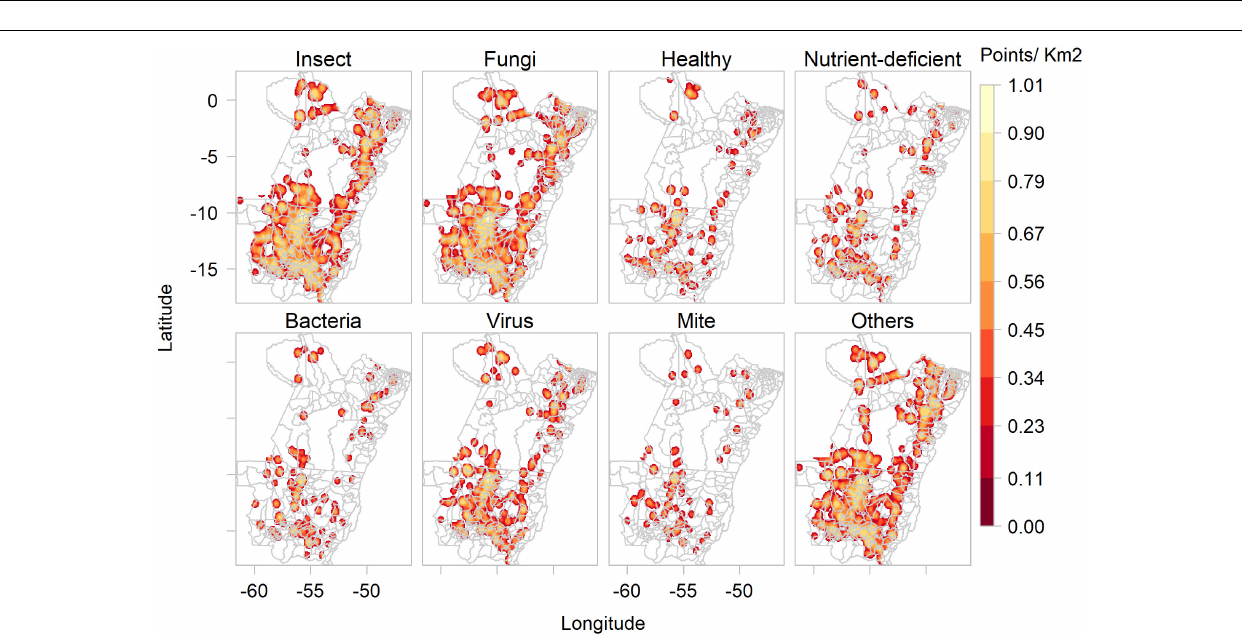
FIGURE 4 | Kernel density of images collected by Plantix users in Mato Grosso and Pará, Brazil, between November 2016 and May 2020, according to predicted crop types.